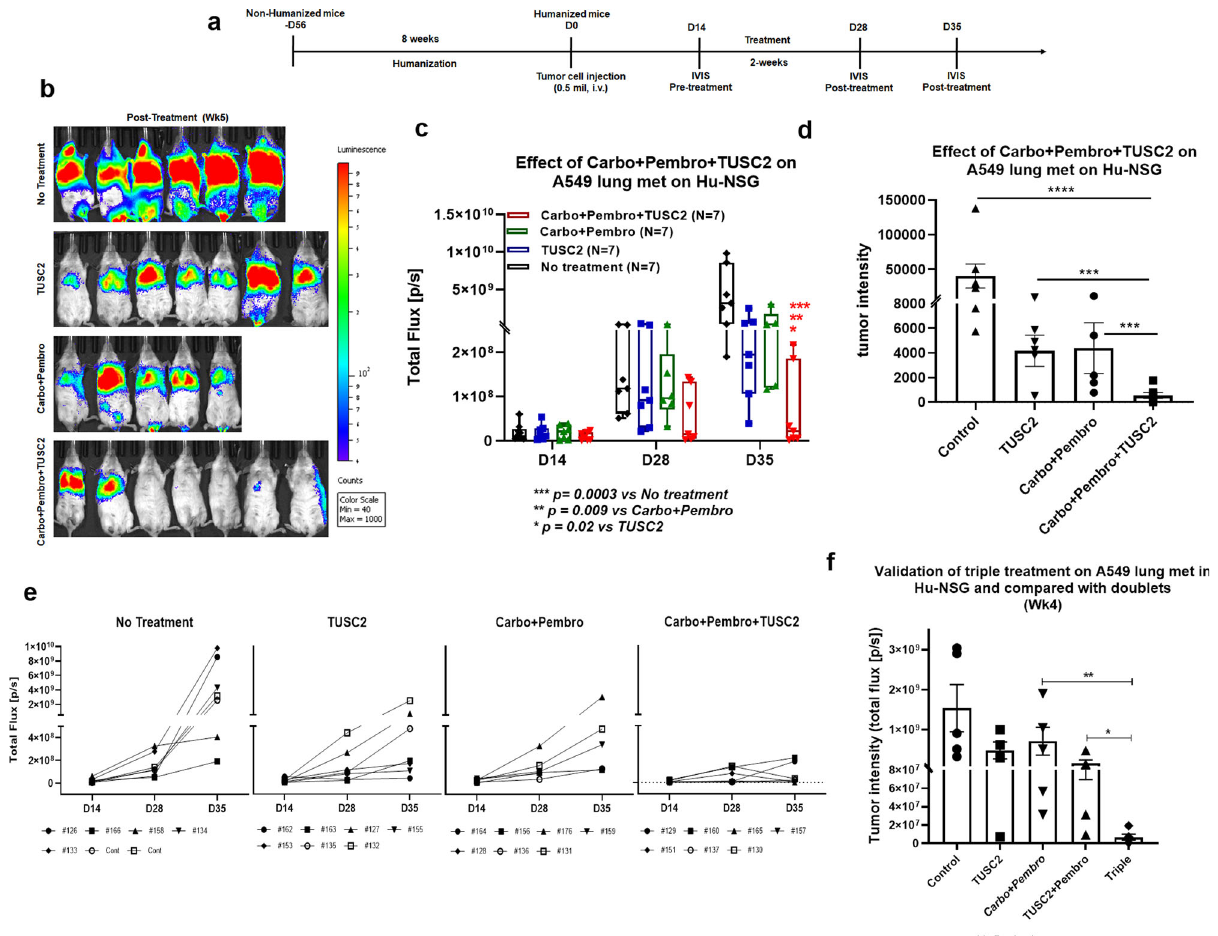
Fig. 3 The TUSC2 immunogene enhances the chemo – immunotherapy combination on KRAS/LKB1 mutant lung metastases in humanized mouse. a Carboplatin, pembrolizumab, and TUSC2 triple combination treatment strategy where 7 – 8 weeks post-humanized mice were implanted with KRAS/LKB1 tumors. After 2 weeks, mice were imaged to determine the level of lung metastases, L and mice were randomized. Lung metastases were treated with carboplatin (10 mg/kg) on every other day for 2 weeks, pembrolizumab (250 ug/mouse) on every 3 – 4 days for 3X, and TUSC2 (25 ug/mouse) on every 3 days for 3X. Mice were imaged at different time points. b Mice were imaged by IVIS 200 for bioluminescence signals coming from tumor cells and tumor burden is shown in different treatment groups. c Tumor intensity was measured through bioluminescence imaging. The growth curve shows the progression of tumor growth among different treatment groups. d Rate of tumor growth was determined by percentage change in tumor intensity between pre- (week 2) and posttreatment (week 5). e Individual mouse response curves are shown in each treatment group to understand the treatment effect on each humanized mouse. f Validation of antitumor activity of triple agent treatment was determined in separate humanized mouse experiments where doublets such as carboplatin + pembrolizumab and TUSC2 + pembrolizumab combinations were compared side by side. The humanized mouse experiment with triple agent treatment was one of three independent experiments using 7 – 8 humanized mice/group. bars, SD. Statistics were shown at a signi fi cance level of p < 0.05 unless otherwise noted. * P < 0.05, ** P < 0.005, *** P <